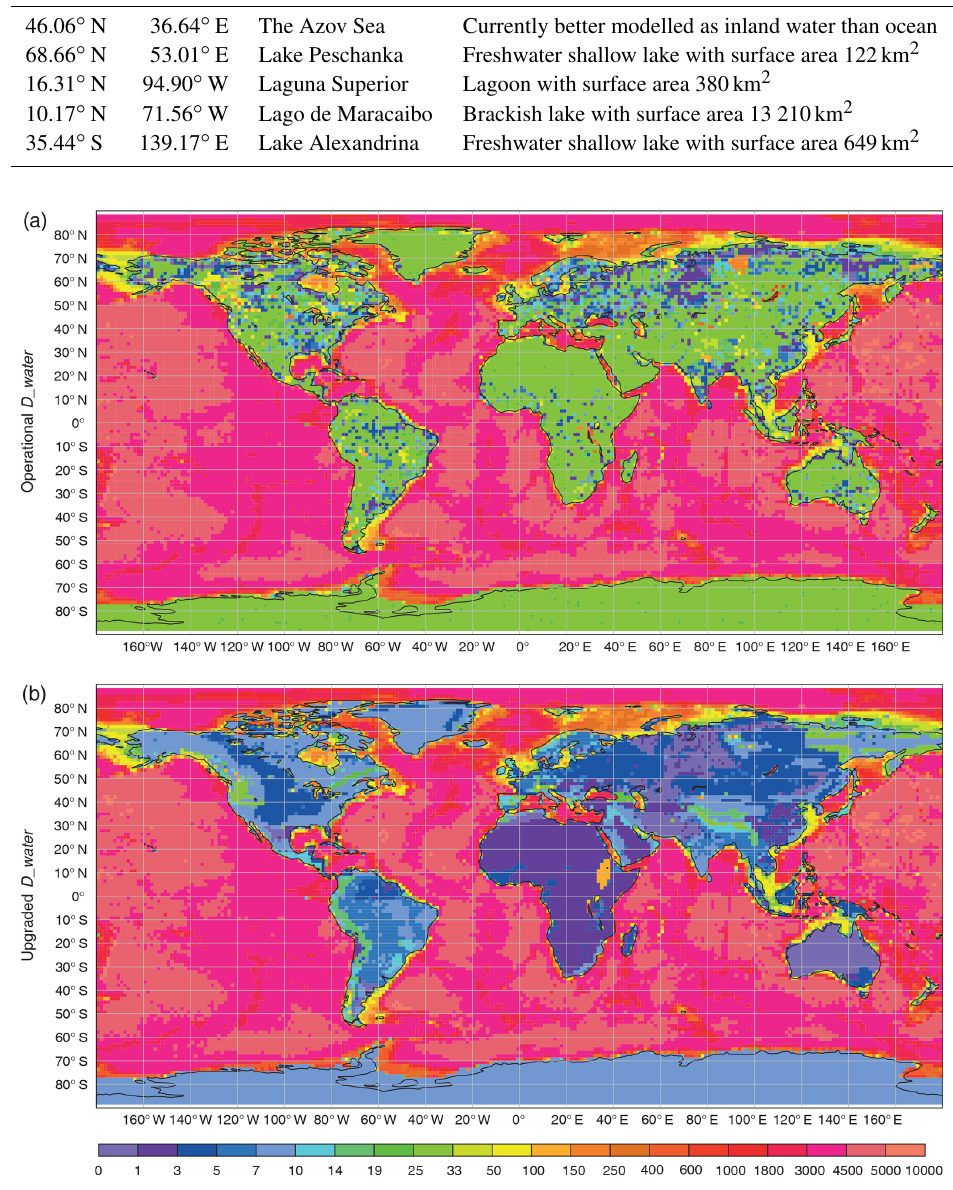
Figure 8. Operational (a) and new (b) depth fields at 9km horizontal resolution (Tco1279); depth values in metres.